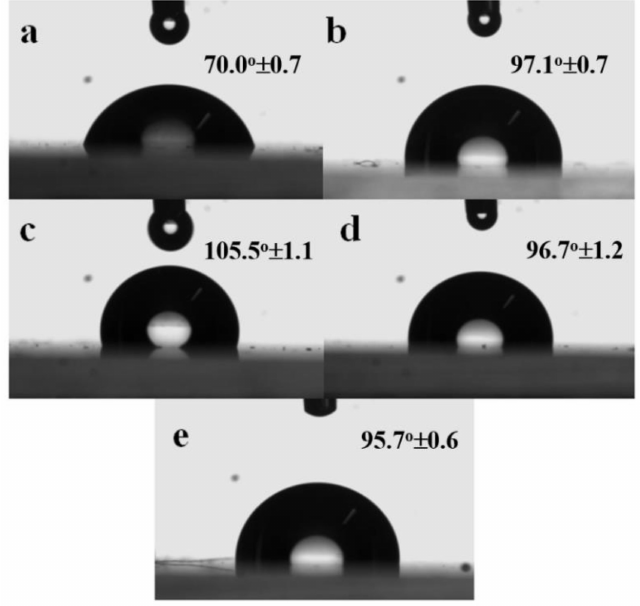
Figure 11. Digital images of water contact angle of ( a ) PCL; ( b ) PIOPOSS-PCL-PIOPOSS; ( c ) PCL/APIBPOSS-5; ( d ) PCL/APIOPOSS-5; and ( e ) PCL/PIOPOSS–PCL-PIOPOSS-5